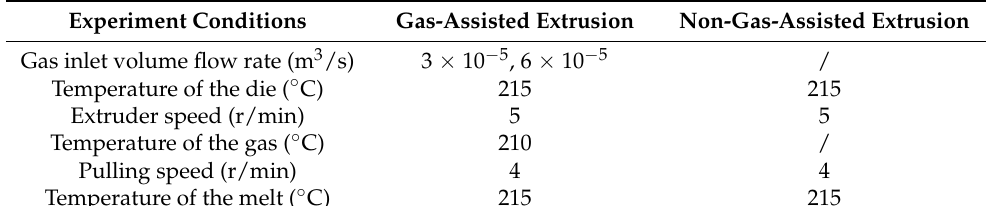
Figure 10. Physical diagram of the extrusion die. ( a ) Connection module for single gas chamber die; ( b ) Connection module for double gas chamber die; ( c ) Die ring. Table 2. Experimental conditions.